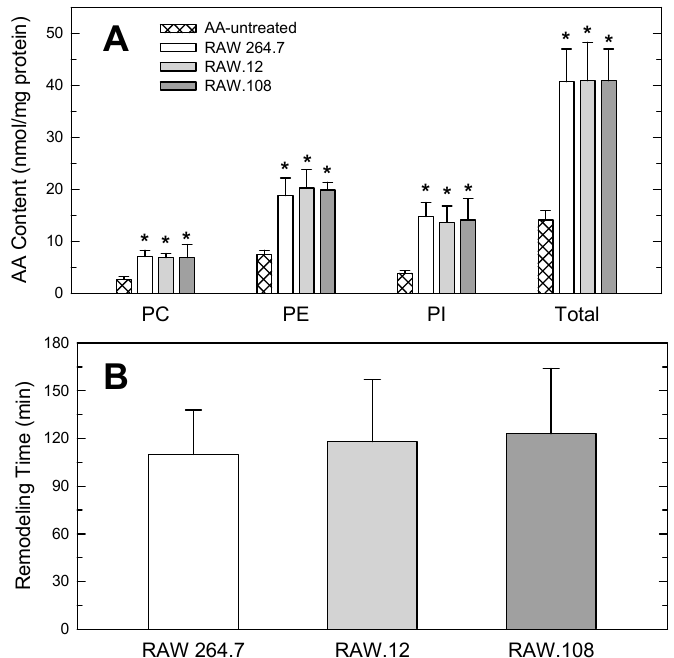
Figure 6. Phospholipid AA remodeling in AA-enriched cells: ( A ) RAW 264.7 cells (open bars), RAW.12 cells (light grey bars), and RAW.108 cells (dark grey bars) were incubated in media containing 25 µ M exogenous AA for 48 h. Afterward, cellular AA content in phospholipids was analyzed by GC / MS. The AA content of otherwise untreated RAW 264.7 cells (cross-hatched bars) is shown for comparison. ( B ) AA remodeling was analyzed in the AA-enriched cells, and the remodeling time (time at which the radioactivity content of PC equals that of PE) was determined. Results are shown as means ± S.E.M. (n = 3). * p < 0.05, significantly different from AA-untreated cells.